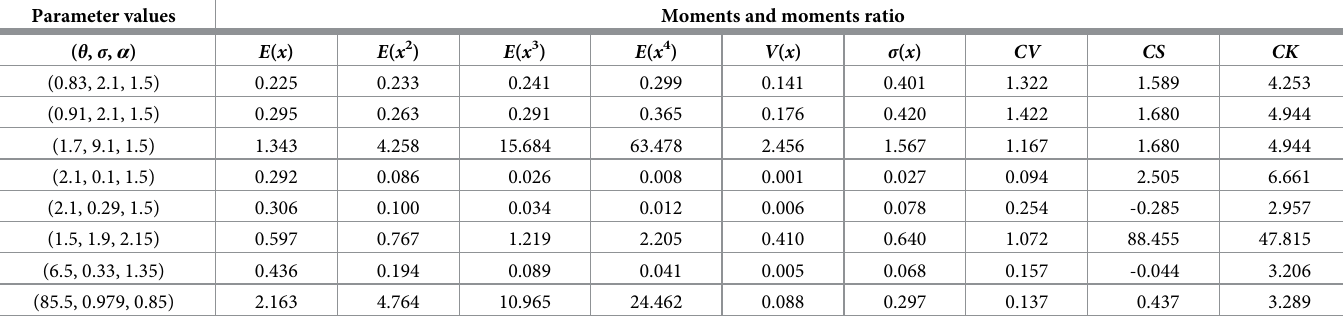
Table 3. Moments and moment ratios of EGuNH for some parameter combinations. Parameter